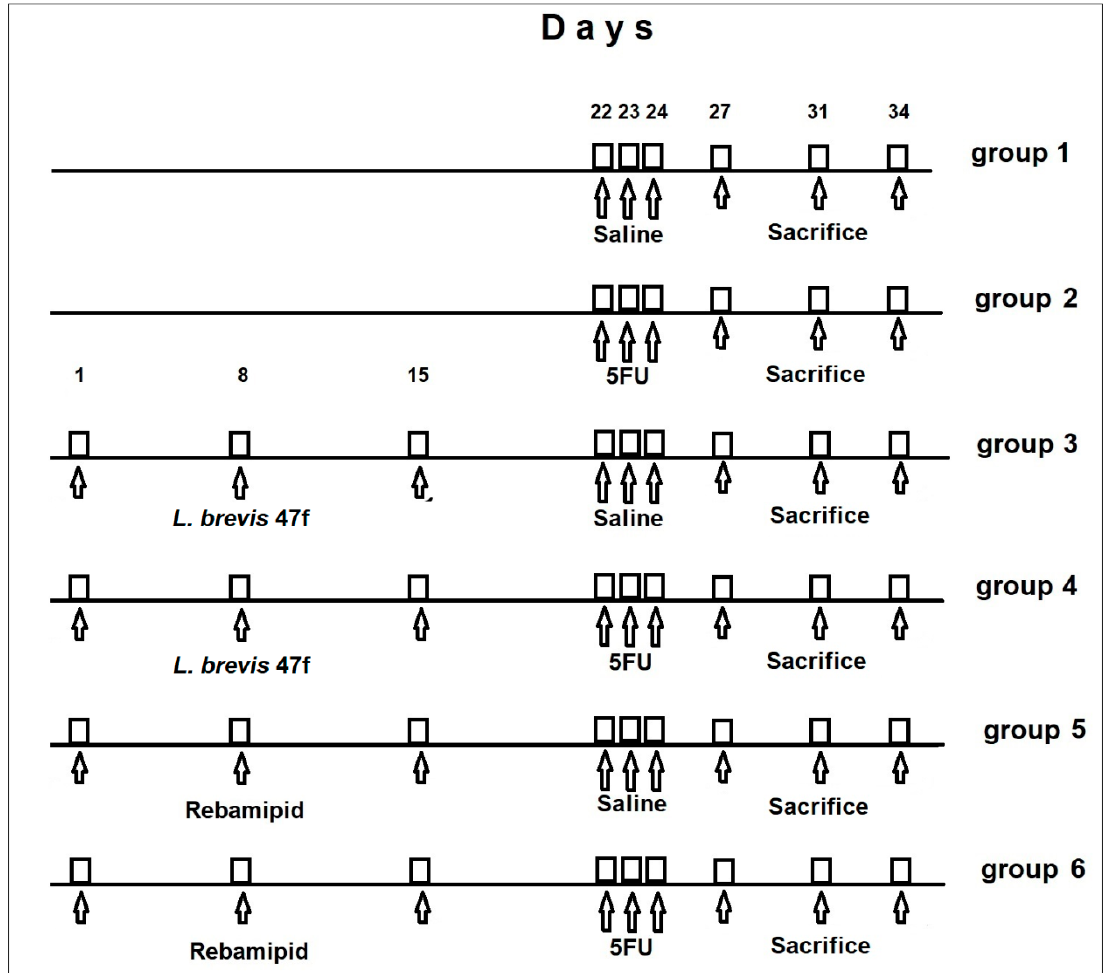
Figure 1. Timeline of animal treatment.